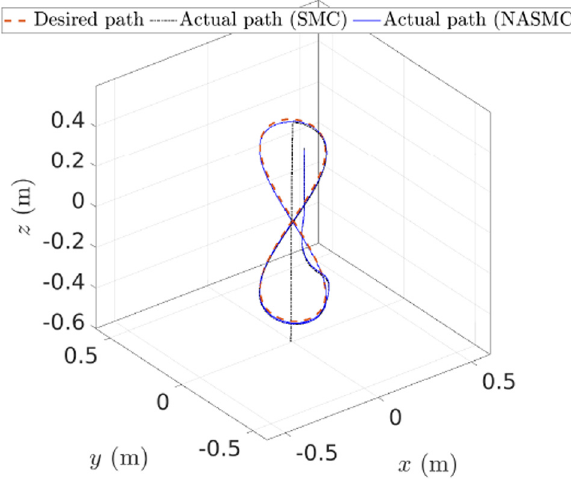
Figure 5: 3D position of the quadcopter system using SMC and NASMC.